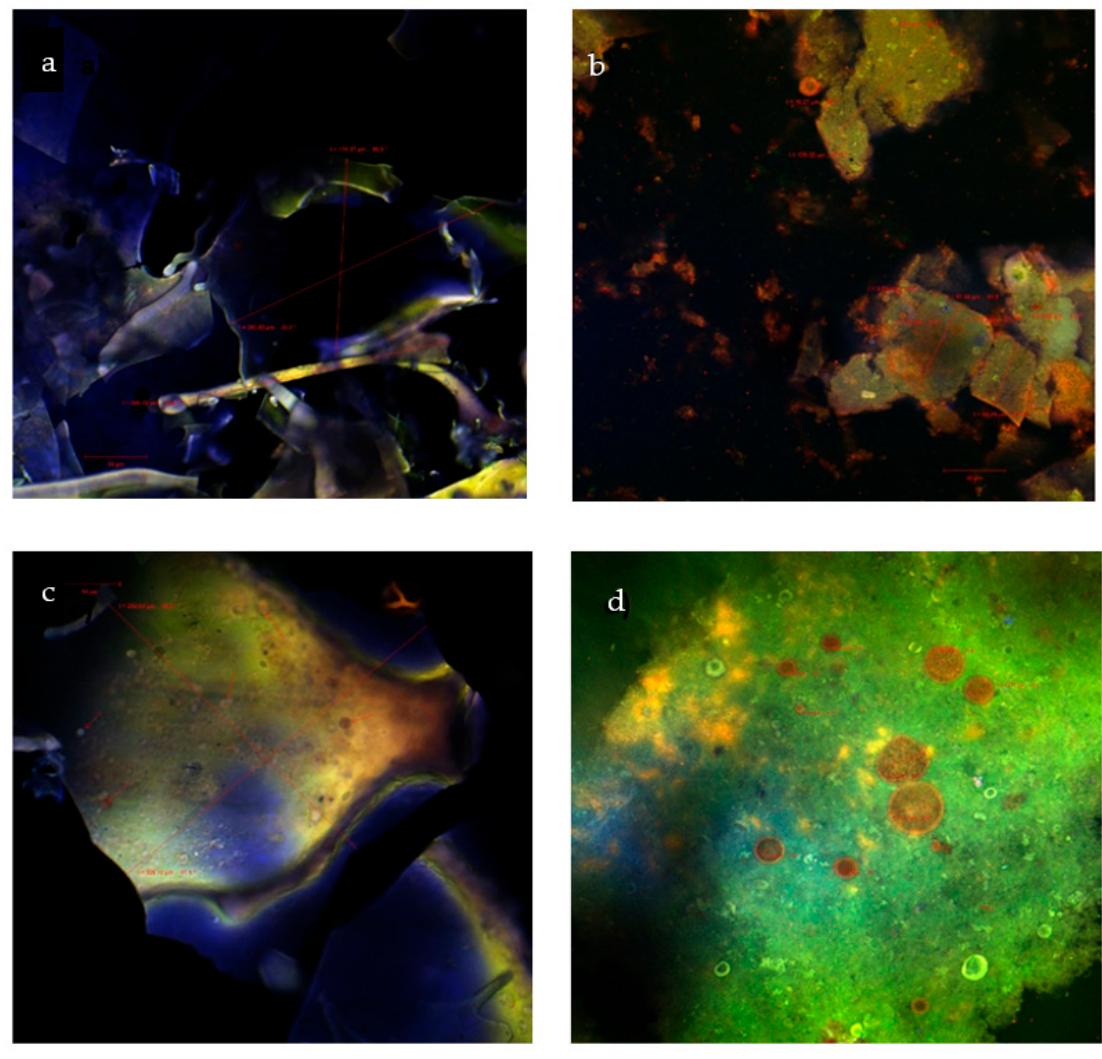
Figure 2. Confocal laser scanning microscopy images of the native microencapsulated powders: variant 1—native state ( a ) and with fluorophores ( b ); variant 2—in native state ( c ) and with fluorophores ( d ).